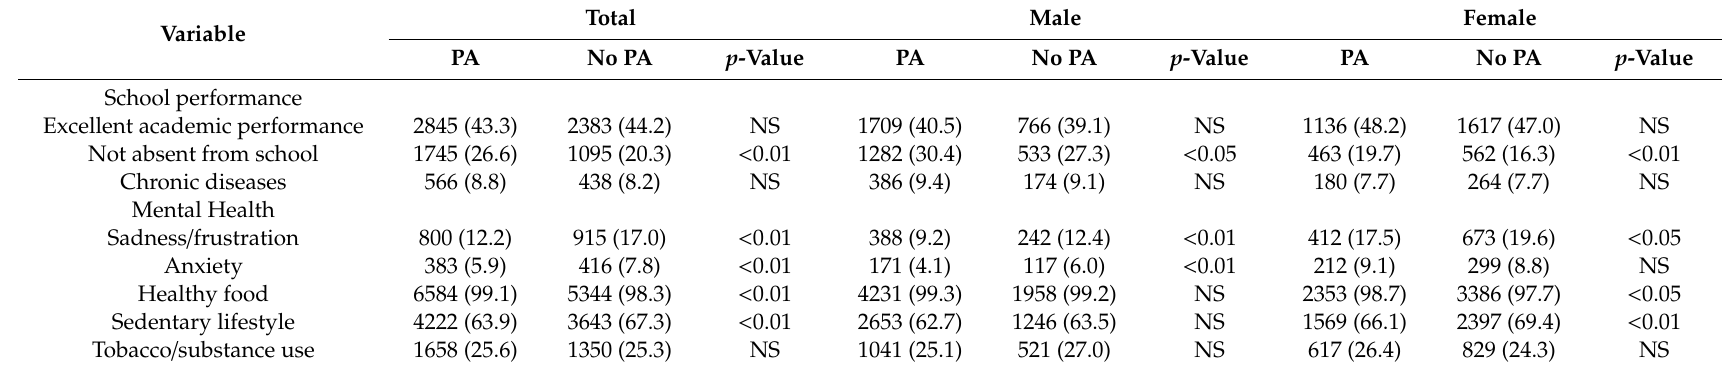
Table 4. Relationship between engaging in PA and school performance, health status, and health risk behaviors among adolescents in Saudi Arabia ( n =